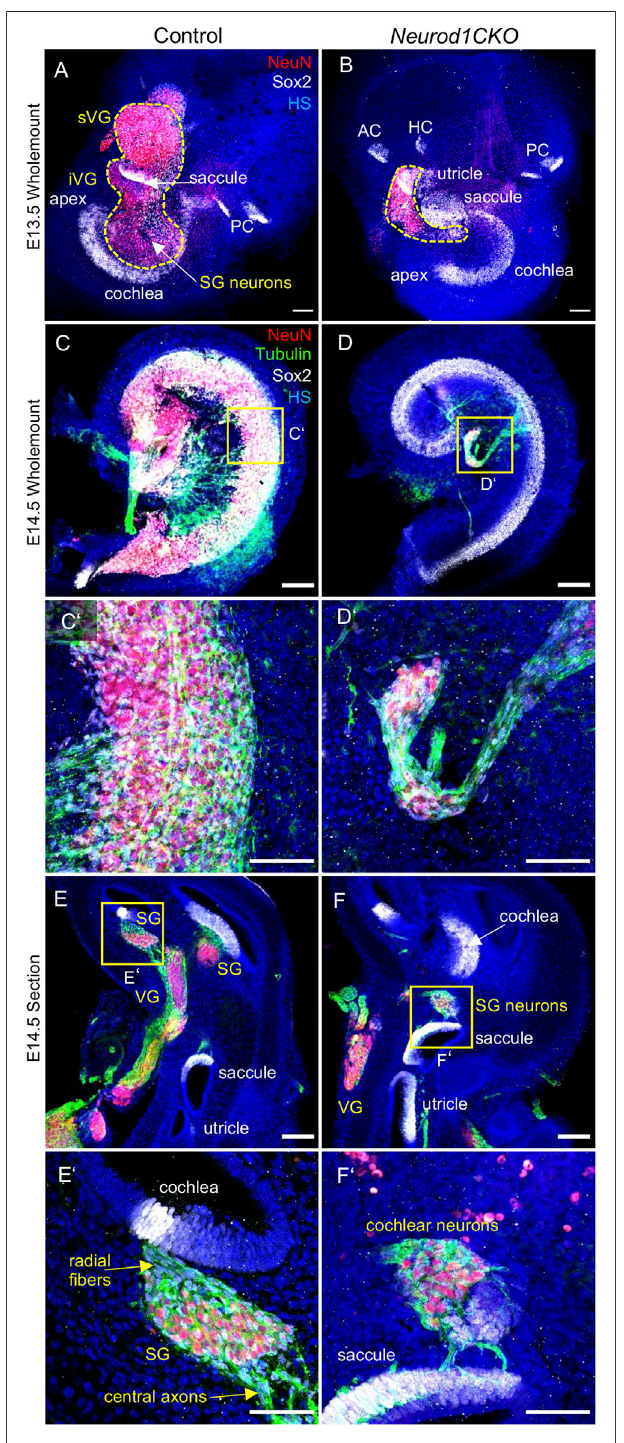
FIGURE 5 | The ganglion formation in the Neurod1CKO cochlea is severely disrupted. (A , B) Representative images of whole-mounted inner ear labeled by anti-NeuN (a marker of differentiated neurons) and SOX2 (a marker of sensory epithelial and glial cells). The dashed line delineates the VG and SG areas containing neurons. (C , D , C ’ , D ’ ) At E14.5, cochlear neurons form the SG along with the sensory cells of the organ of Corti in the control